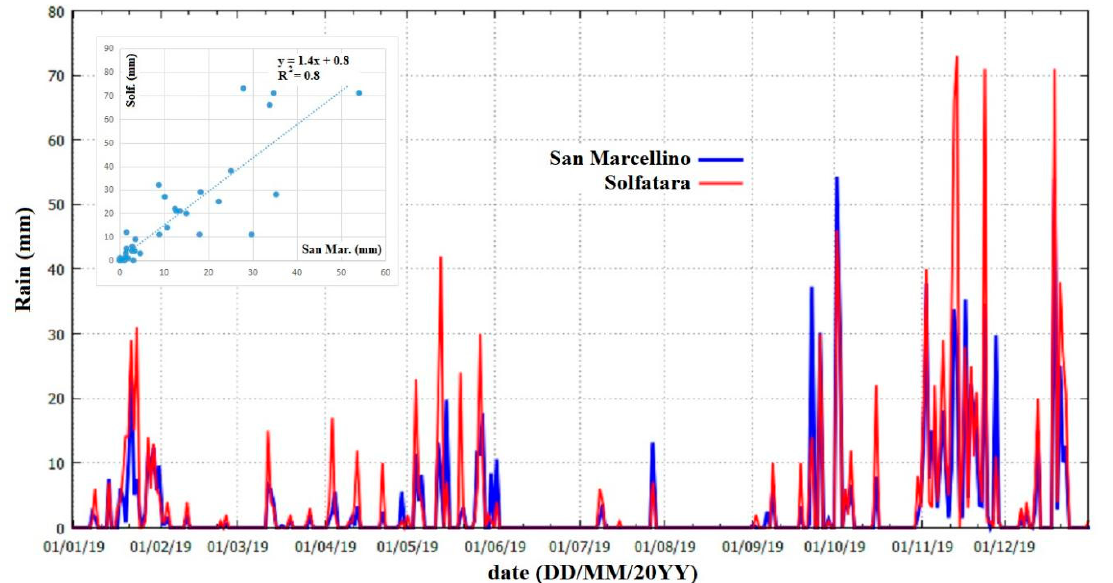
18 of 20 Figure A1. Time series of changes in altitude of the RITE station (Pozzuoli-Rione Terra), ACAE (Accademia Aeronautica), SOLO (Solfatara), and STRZ (Pozzuoli-Cemetery) from January 2000 to May 2020 (modified from: INGV-OV Bulletin of